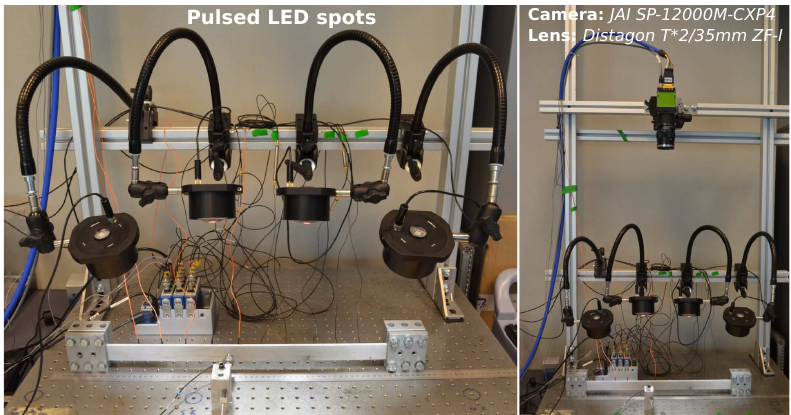
Figure 1. Experimental